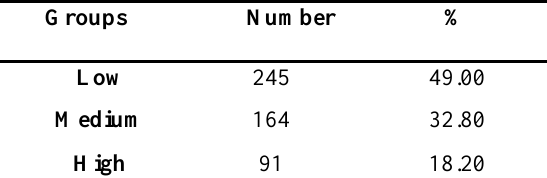
Table 1: Distribution of the sample according to depression